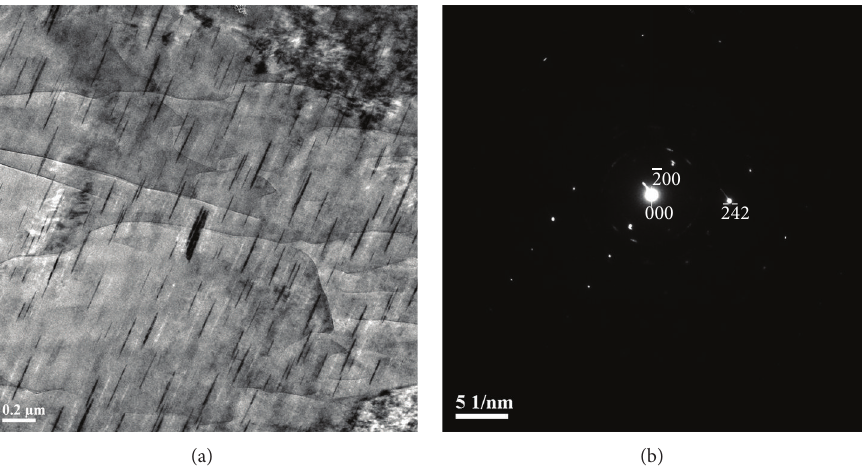
Figure 7: TEM image and electron diffraction pattern showing precipitates aged at 225 ∘ C for 64h along [012] 𝛼 zone axis: (a) TEM image; (b) electron diffraction pattern.